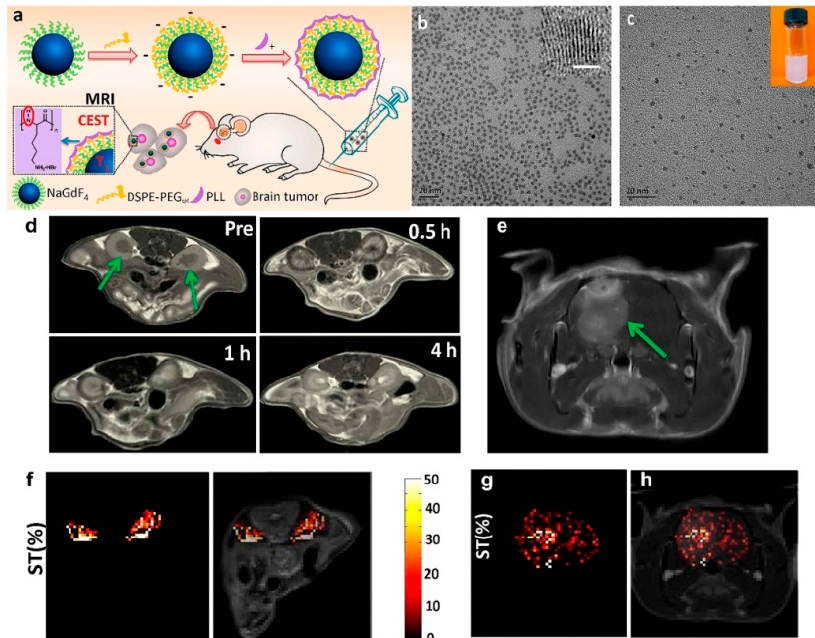
Figure 8. ( a ) Schematic representation of the synthesis of NaGdF 4 @PLL NDs for T 1 -weighted and chemical exchange saturation transfer (CEST) MR imaging. ( b ) TEM and HRTEM (inset, scale bar: